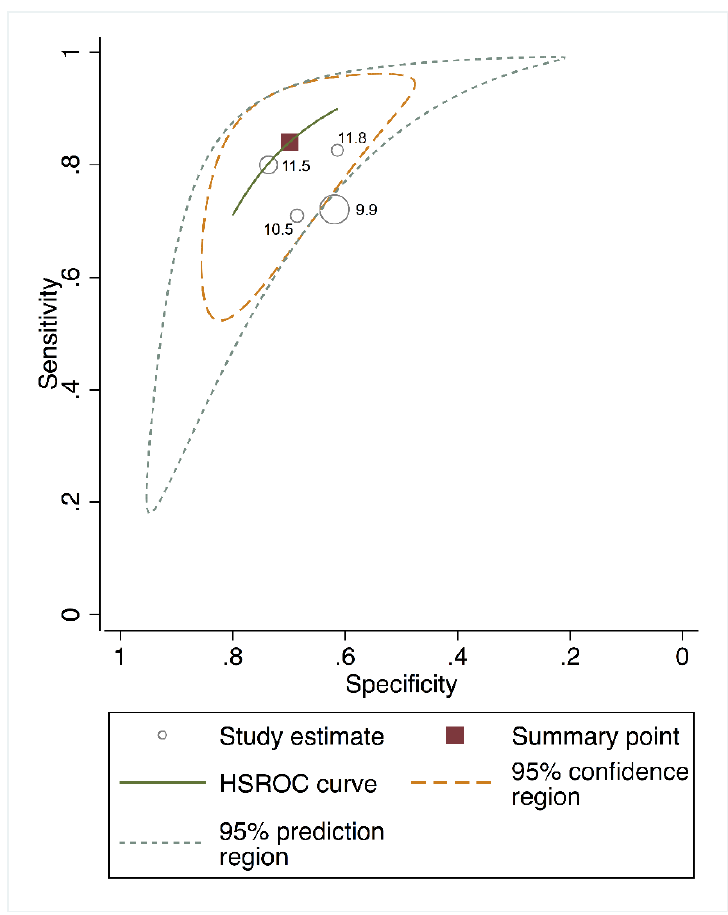
Figure 3. Hierarchical summary receiver operating characteristic curves (HSROC) curve for cfPWV predicting all-cause mortality.